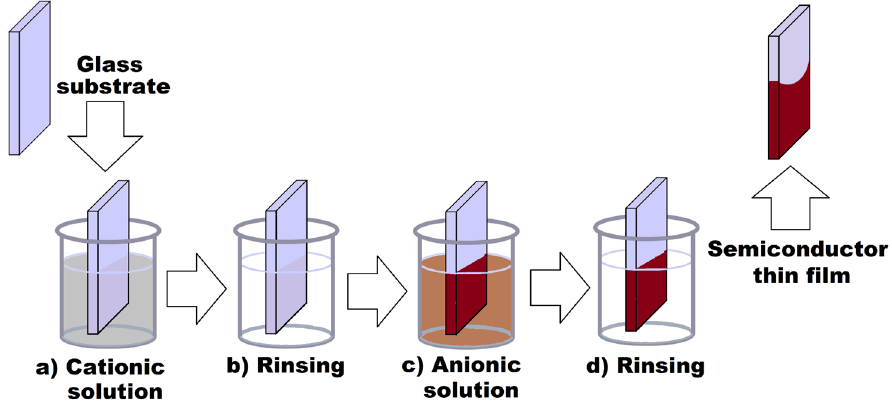
Figure 1. SILAR process.